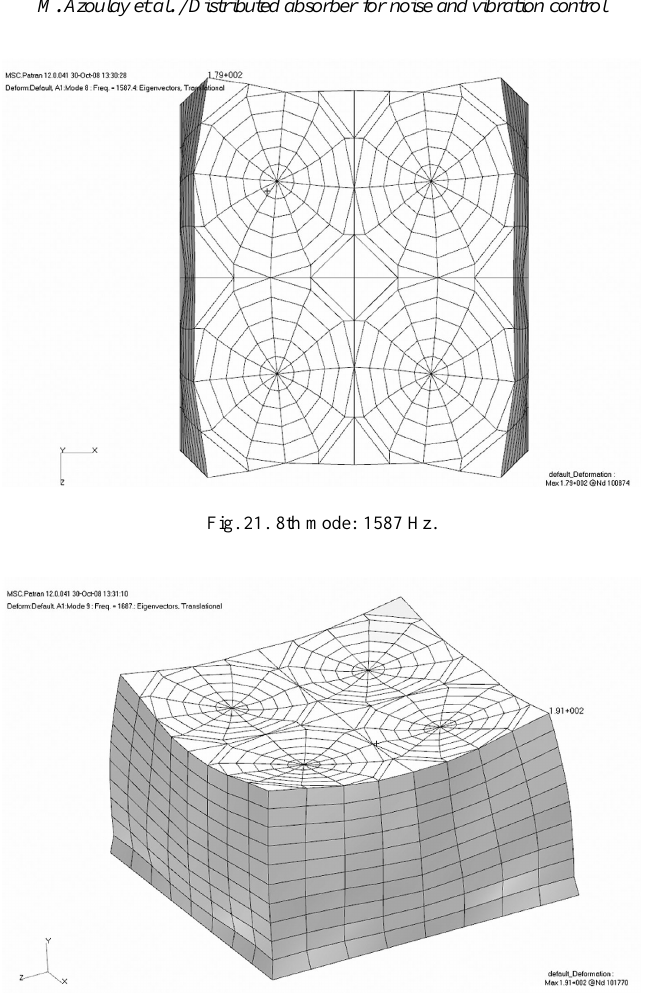
Fig. 22. 9th mode: 1687 Hz – Y translation (axial) (single cell-1982 Hz).